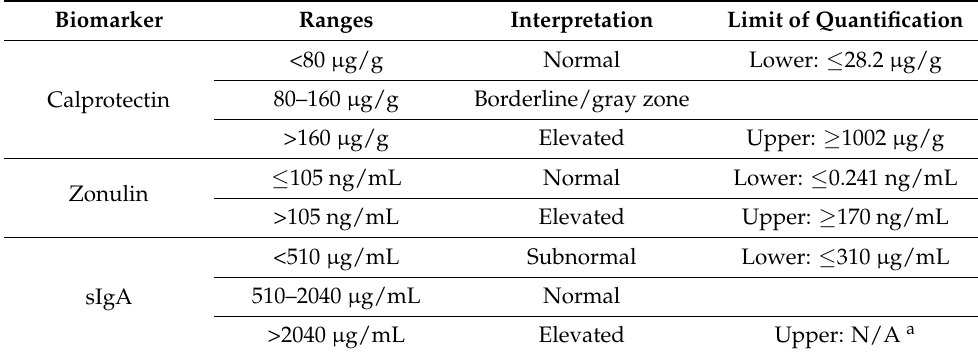
Table 1. Reference ranges for biomarkers, interpretation, and detection